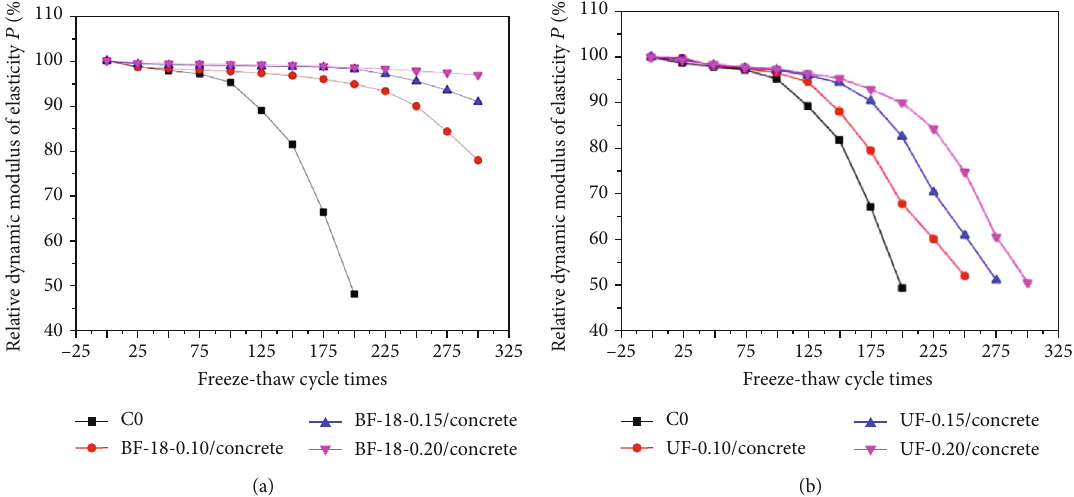
Figure 2: (a) The relative dynamic elastic modulus of basalt fi bers and (b) CF with di ff erent fi ber volume fraction changes with the number of freeze-thaw cycles